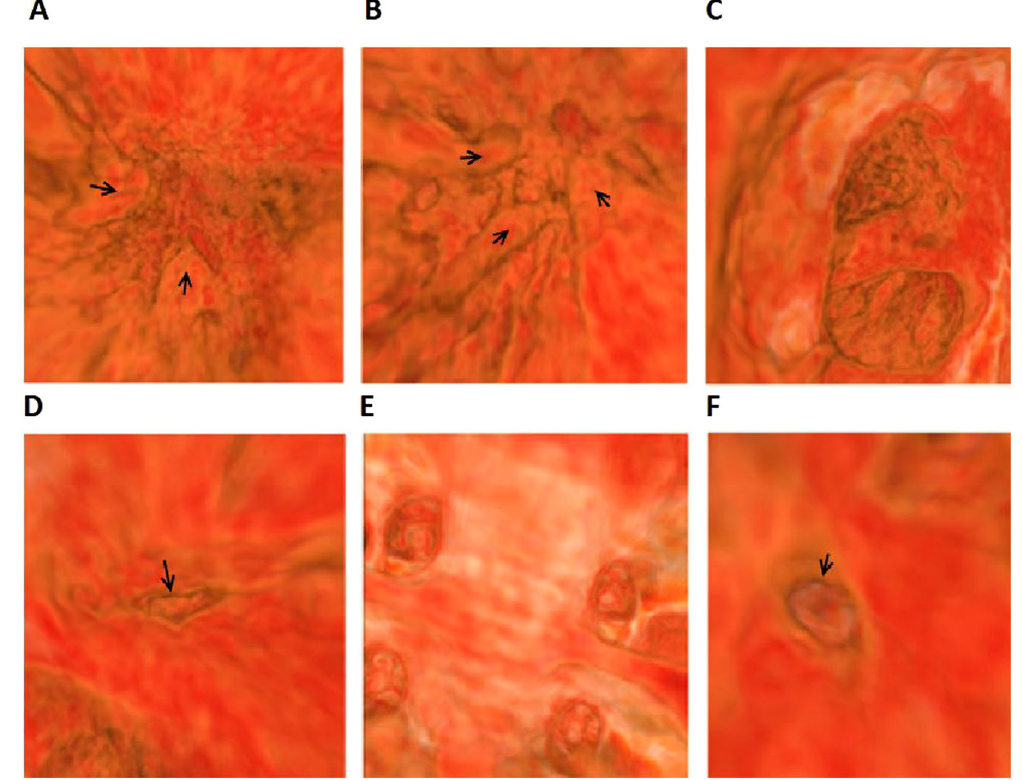
Figure 3. A five-year-old girl diagnosed as TOF with a muscular-VSD under VE. Figure A and B showed left and right ventricles, there were two groups of papillary muscles (arrow) in the left ventricle and three groups of papillary muscles (arrow) in the right ventricle. Figure C showed aortic overriding, figure D showed the stenosis mouth (arrow) in right ventricle outflow tract, figure E showed four pulmonary venous openings in left atrium and figure F showed a little muscular-VSD